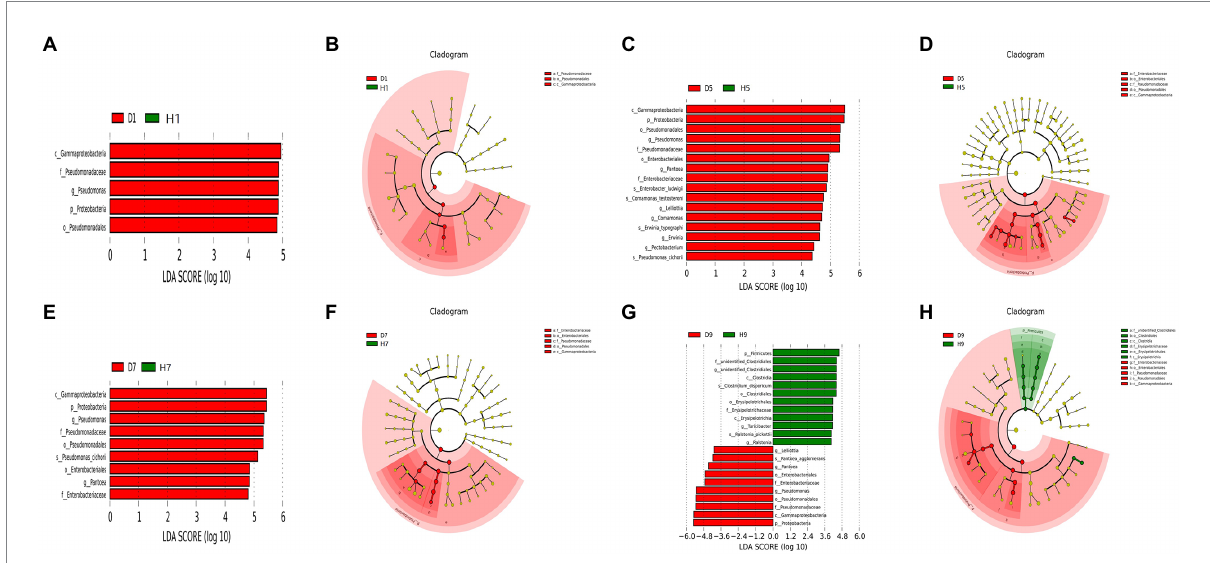
FIGURE 8 LEfSe analysis of bacteria abundance between diseased and healthy samples of different disease severities. (A) , ( C ), ( E ), (G) are LDA score identified the size of differentiation between diseased and healthy groups of S1, S5, S7, S9, respectively, with a threshold value of 4. (B) , (D) , (F) , (H) are the cladogram of microbial communities of S1, S5, S7, S9, respectively.